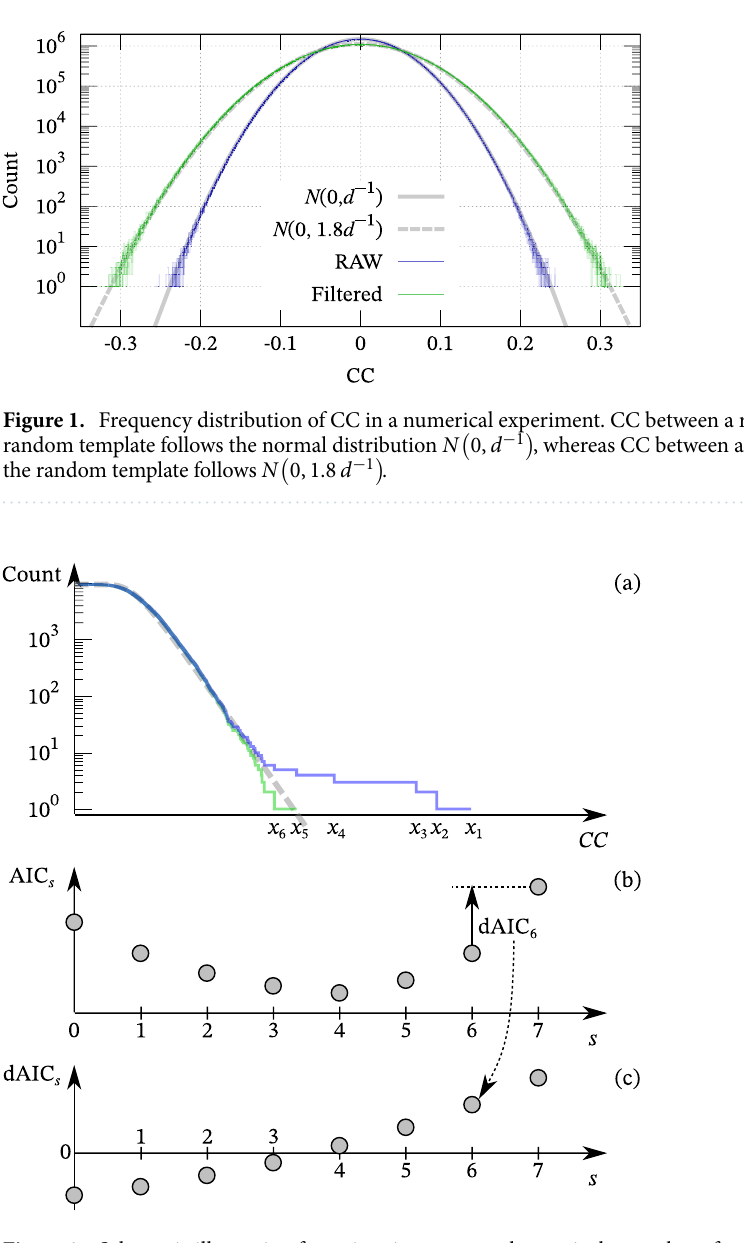
Figure 2. Schematic illustration for estimating s 0 = 4 , where s 0 is the number of outliers out of N = 10 4 . ( a ) Cumulative number of raw data (blue steps), estimated Gumbel distribution (gray broken line), and cumulative number of data after elimination of x 1 , . . . , x s (green steps). ( b ) Dependence of AIC on the number of 0